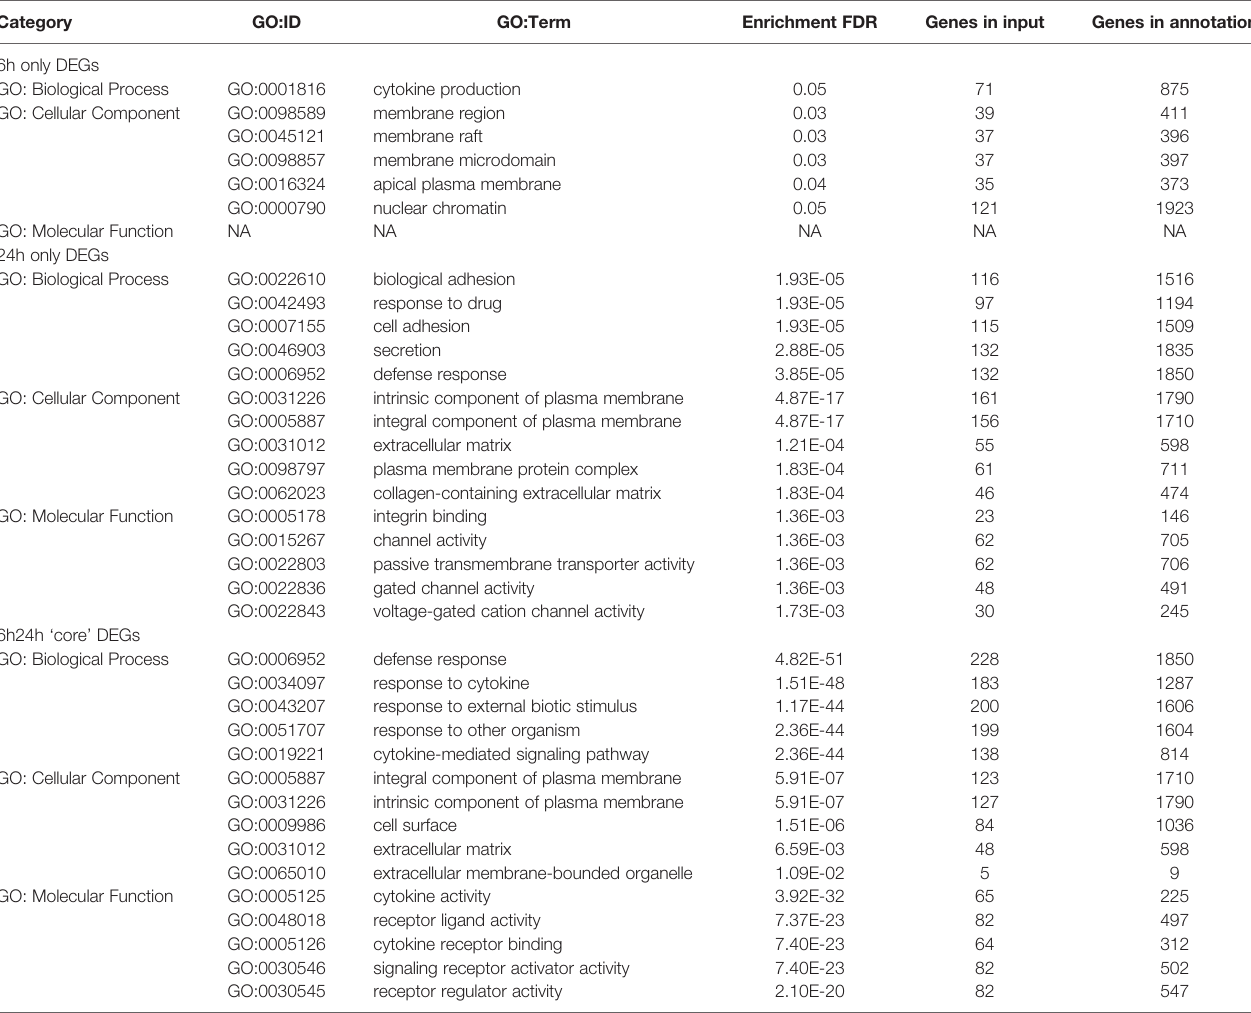
TABLE 1 | Time-dependent enrichment of macrophage processes during NTHi